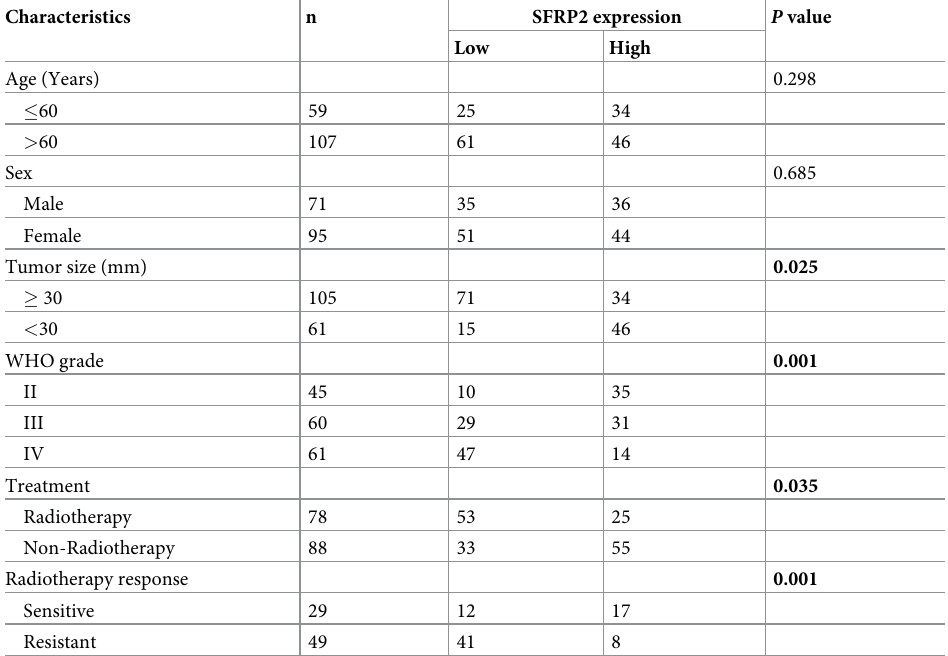
Table 1. Correlation between SFRP2 expression and clinicopathological characteristics of glioma patients.